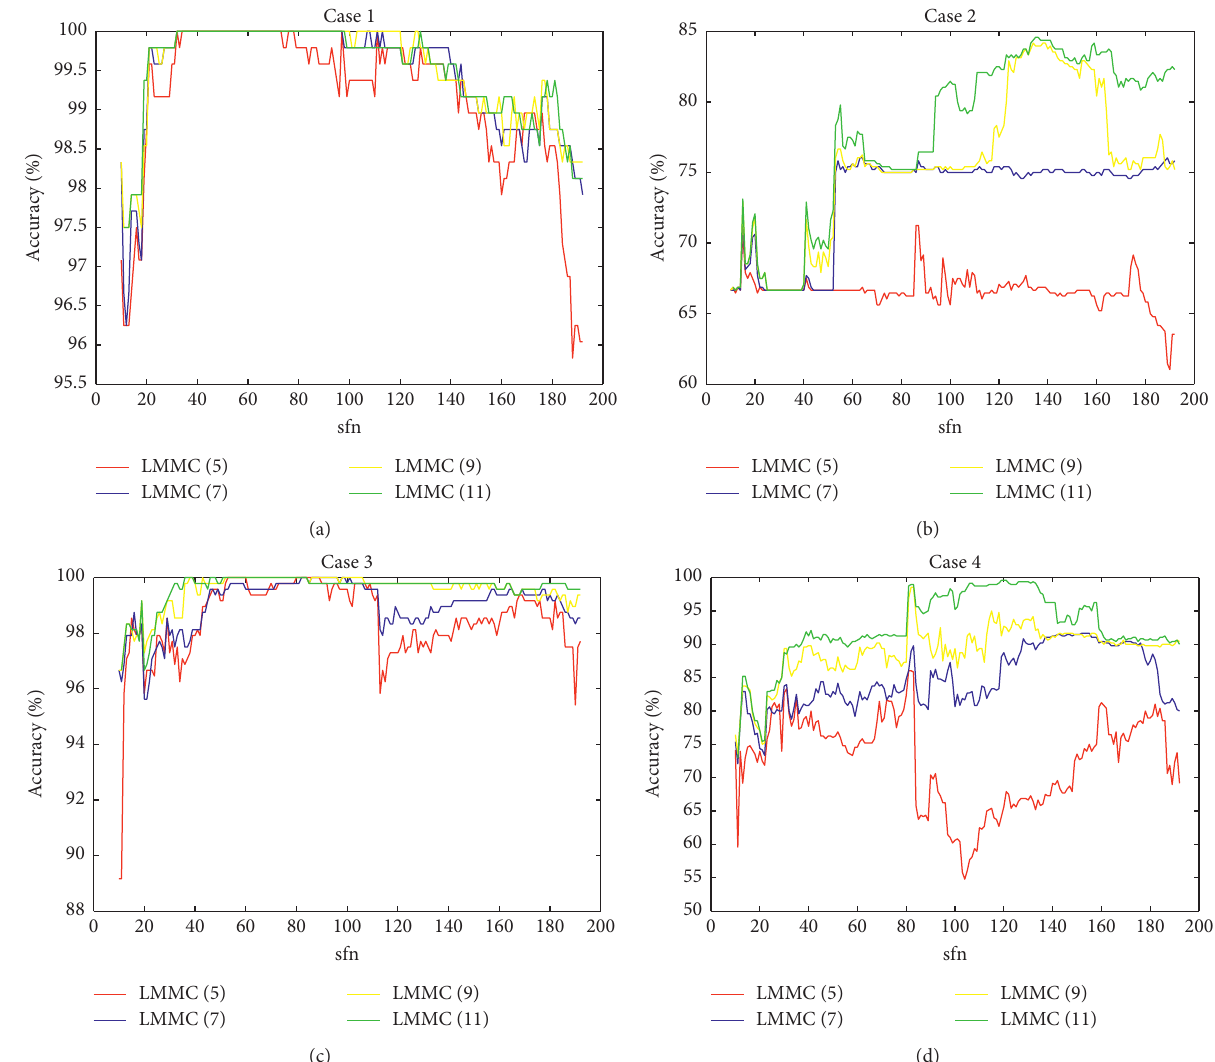
Figure 17: The curve representation of diagnosis results obtained by OFS-TSFRS-LMMC-SVM using WPT with different number of dimension sizes for LMMC. The LMMC (5) represents that the number of dimension size is